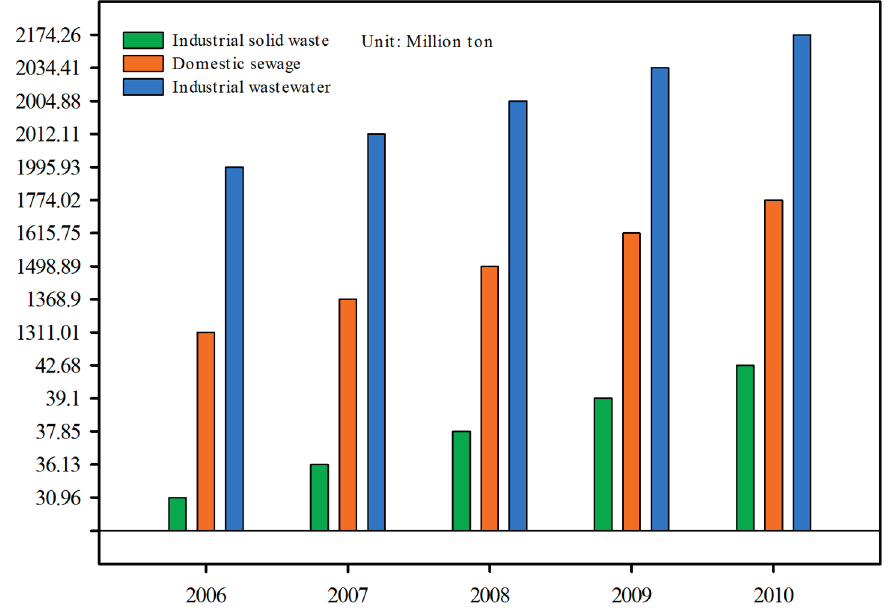
Figure 6. The industrial wastewater, industrial solid waste, and domestic sewage emissions in Zhejiang Province between 2006 and